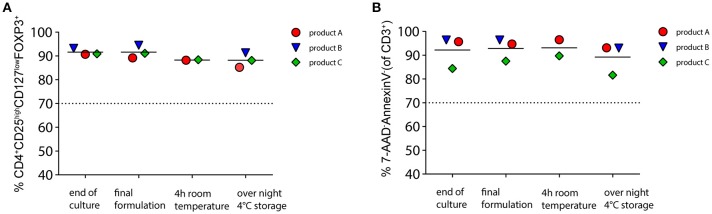
Stability of phenotype and vitality of the final cellular product. Three Treg products manufactured by automated culture were stored for 4 h in infusion solution (0.9%NaCl + 1% human albumin) at room temperature or overnight at 4°C. (A) Stability of Treg phenotype before and after storage as percentage of CD4+CD25highCD127lowFOXP3+ of CD45+. (B) Viability of cells determined by 7-AAD/AnnexinV staining. Shown are the percentages of viable non-apoptotic cells of total CD3+. Broken line indicates our release criteria value.